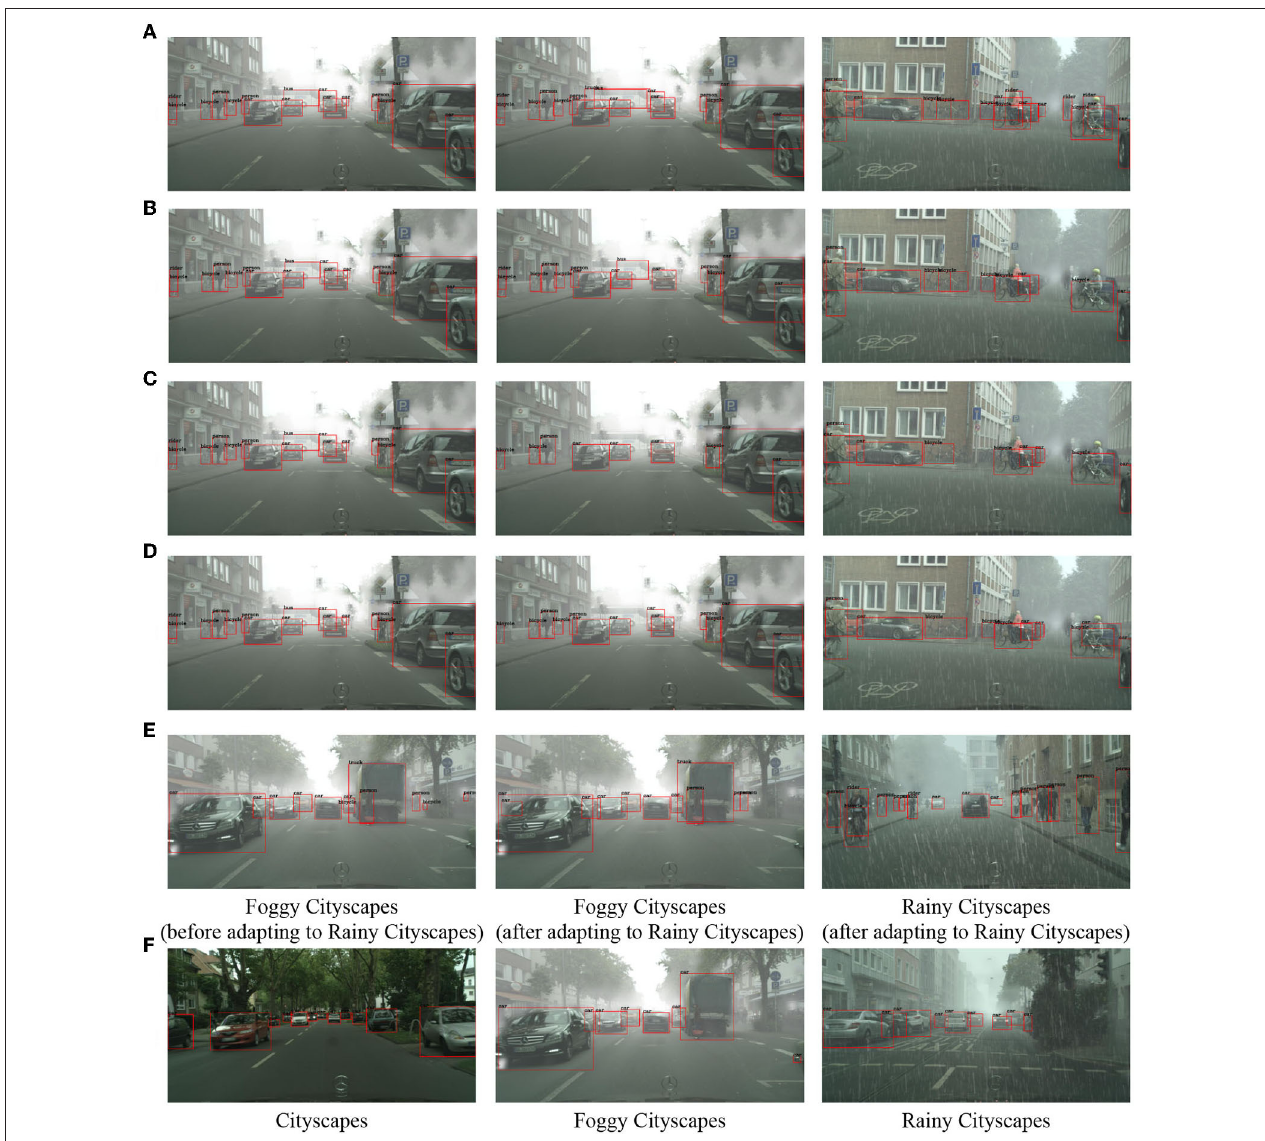
FIGURE 7 | Visualized detection results on each series of experiments. The red rectangles indicate the locations of objects. (A) “Diverse Weather” with Methods of Section 3 (Proposed Framework). (B) “Diverse Weather” with Methods of Section 3 (PFT). (C) “Diverse Weather” with Methods of Section 3 (MIX). (D) “Diverse Weather” with Methods of Section 3 (FT). (E) “Diverse Weather” with HTCN. (F) “Virtual to Real” with Methods of Section